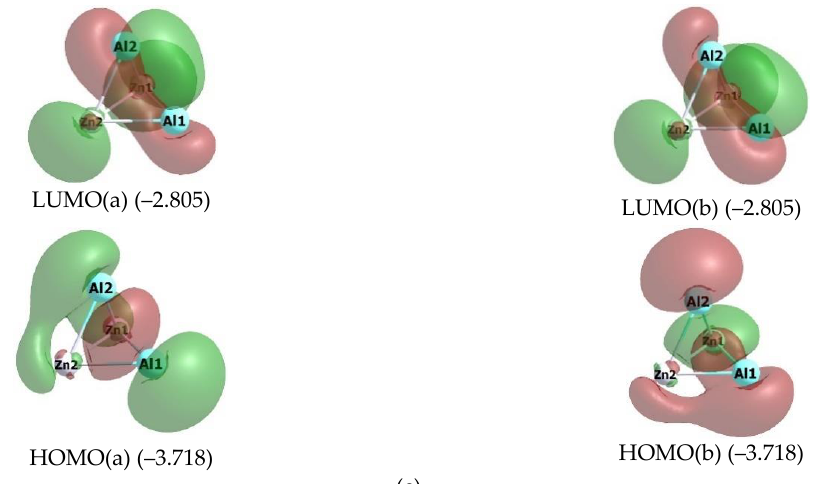
Figure 3. Images of highest occupied (HOMO) and lowest unoccupied (LUMO) molecular orbitals in the Al 2 Fe 2 (5-I) ( a ), Al 2 Co 2 (5-I) ( b ), Al 2 Ni 2 (1-I) ( c ), Al 2 Cu 2 (1-I) ( d ), and Al 2 Zn 2 (1-I)* ( e ) metal clusters. The values of energies of these molecular orbitals (in brackets) are given in eV. The symbol “a” corresponds to electron with spin (+1/2), “b”, to electron with spin (–l/2).